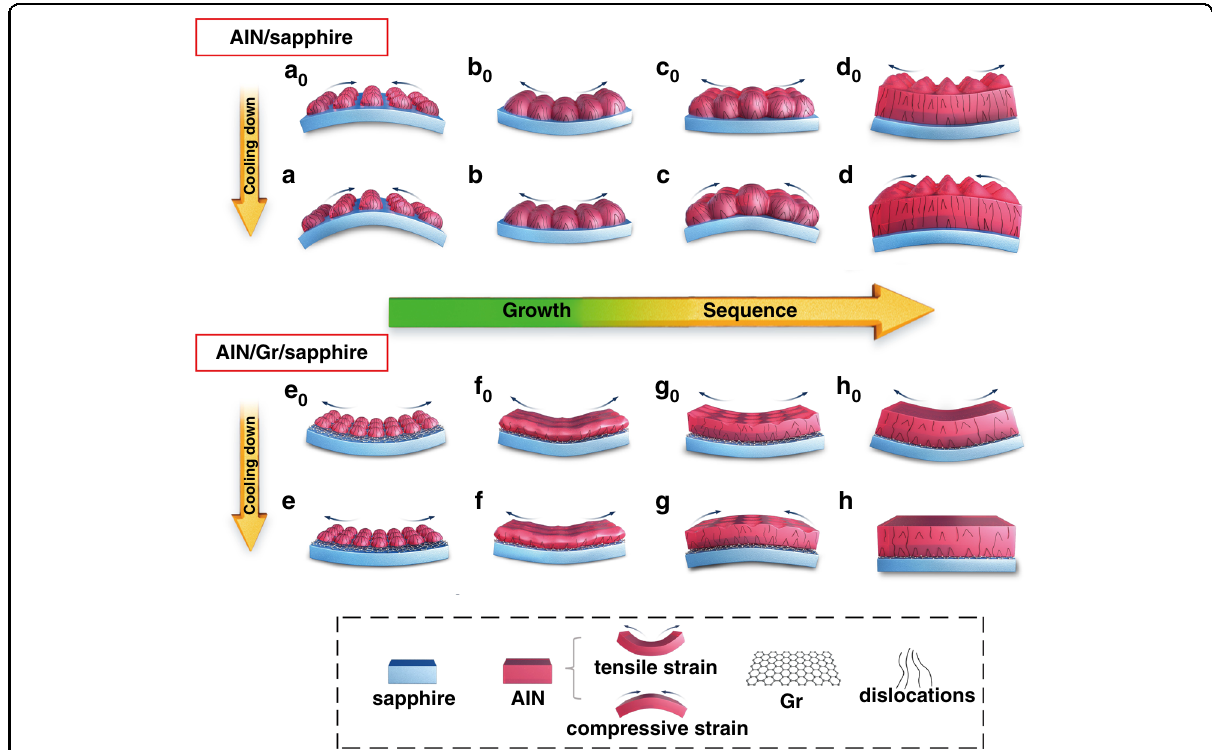
Fig. 5 Schematic diagrams of the epitaxial process of AlN fi lm grown on Gr/Sapphire. The growth development of AlN fi lms without [( a 0 ) – ( d 0 ) and ( a ) – ( d )] and with Gr [( e 0 ) – ( h 0 ) and ( e ) – ( h )] during the processes from nucleation growth [( a 0 ) – ( a ) and ( e 0 ) – ( e )] to nucleation island coalescence [( b 0 ) – ( b ) and ( f 0 ) – ( f )] to completion of coalescence [( c 0 ) – ( c ) and ( g 0 ) – ( g )] and fi nal fi lm formation [( d 0 ) – ( d ) and ( h 0 ) – ( h )]. All the pictures with “ 0 ” subscripts present the state of processes under high-temperature growth (not cooled to RT) and the images without “ 0 ” subscripts show the state after cooling down to room